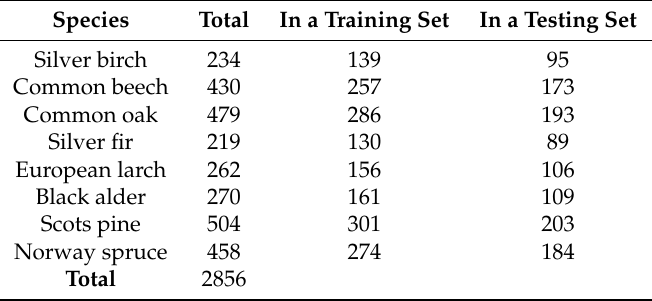
Figure 1. Map of the locations of sample plots. On each sample plot 8 trees have been cut for sectional measurement. Table 1. The number of trees in the subsets after data